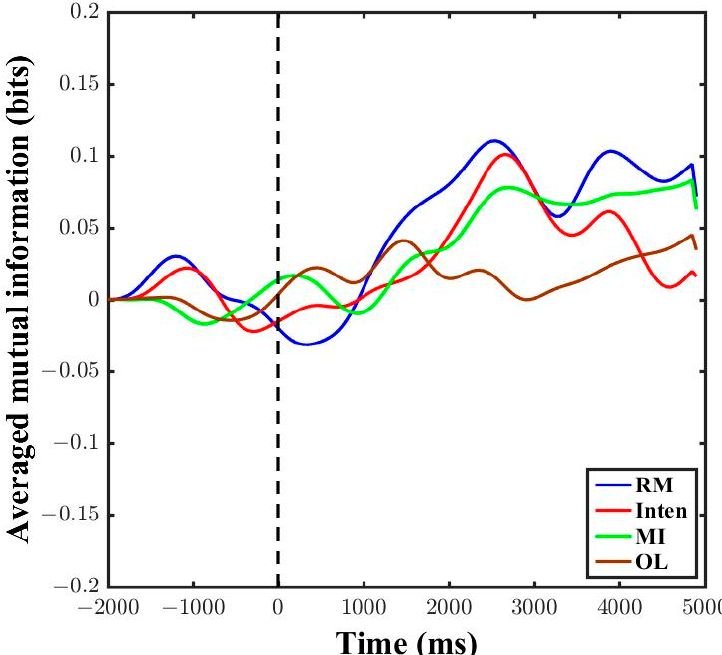
Figure 9. Comparison of mutual information in time series of data from all subjects across all motor task conditions. The black vertical dotted line represents the point at which the participants were given the motor task instructions.